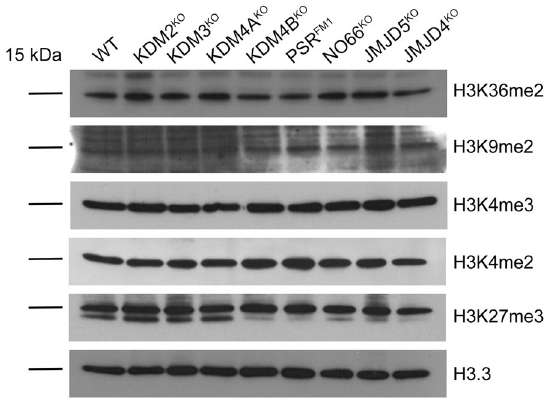
Figure 4. JmjC mutants do not exhibit global changes in selected histone marks. Immunoblots of histones extracted from whole flies of the indicated mutants probed with anti-H3.3 to show similar loading levels and five antibodies that may be targeted by at least one mutant. Blots were cropped to show the 15 kDa bands. Brightness/Contrast levels were not modified. Full-length blots can be found in the supplementary